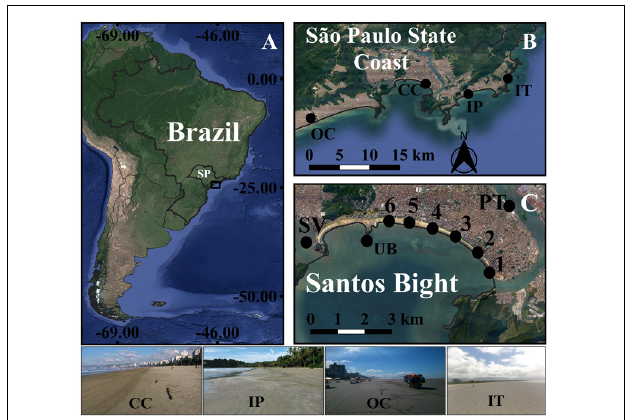
FIGURE 1 | Study sites included in the multi-scale assessments of spatio-temporal variation in plastic pellet pollution; (A) Brazil, showing the location of São Paulo state (SP). (B) Regional-scale study including Ocian (OC), Canal cinco (CC), and Iporanga (IP) and Itaguaré (IP). (C) Small scale replicates within Santos Bight, dots with number represent the sampling locations (1, 2, 3, 4, 5, 6), PT indicates the location of Santos Port Terminal, UB is Urubuqueçaba Island and SV is São Vicente